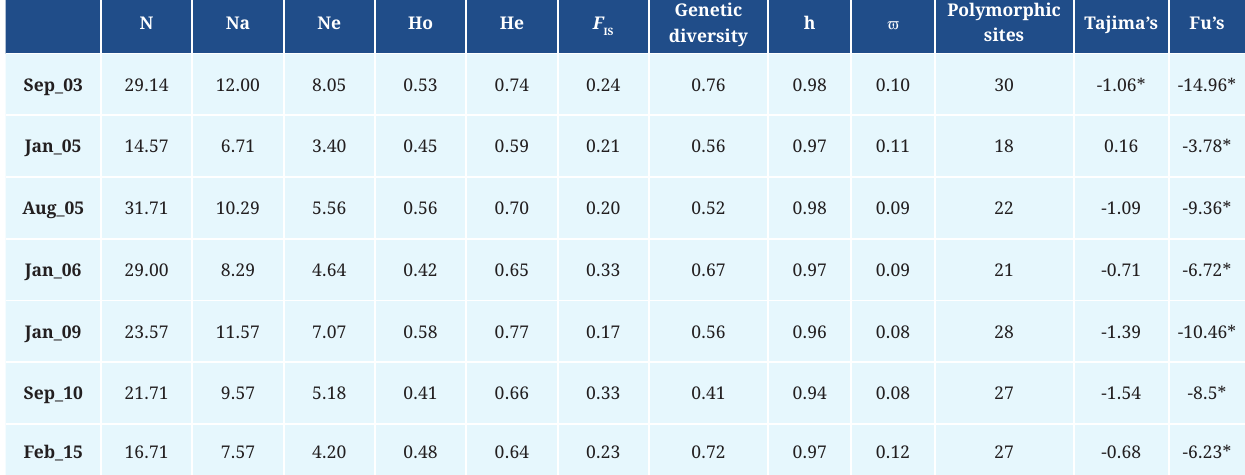
TABLE 3 | Genetic variability data and results of Tajima’s D and Fu’s Fs neutrality tests in different groups of Prochilodus lineatus through microsatellite and D-loop markers. N: number of samples; Na: number of average alleles; Ne: number of effective alleles; Ho: observed heterozygosity; He: expected heterozygosity; F : intrapopulation index. h: haplotype diversity, π: nucleotide diversity. * Statistically IS significant values at the level of